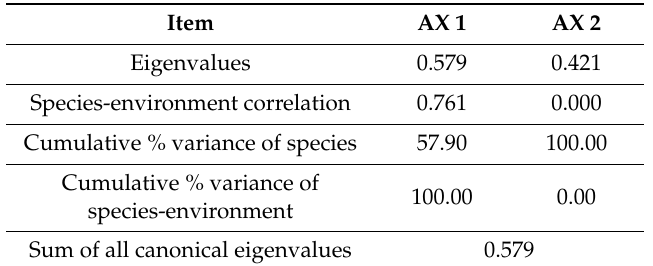
Table 2. RDA results between SOC content and environmental variables.